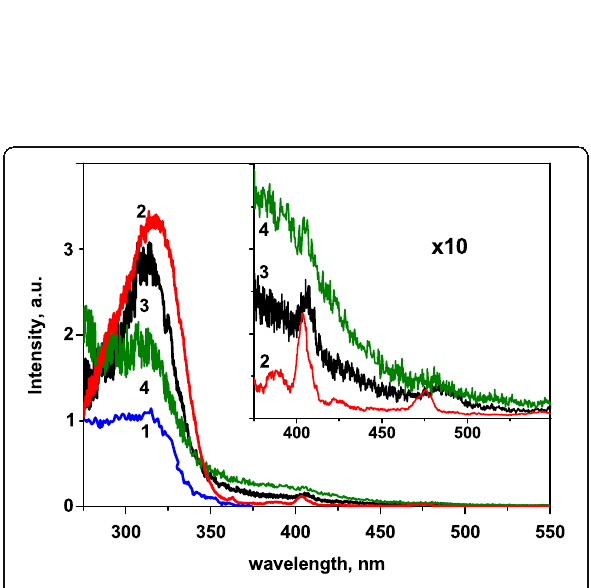
Fig. 8 Excitation spectra of the LaVO4 ( 1 ), La0.9Eu0.1VO4 ( 2 ), and La0.6Eu0.2Ca0.2VO4 ( 3 , 4 ) samples at λ em = 550 ( 1 ), 614 ( 2 , 3 ), and 622 nm ( 4 ); T = 77 K ( 1 ), T = RT ( 2 – 4